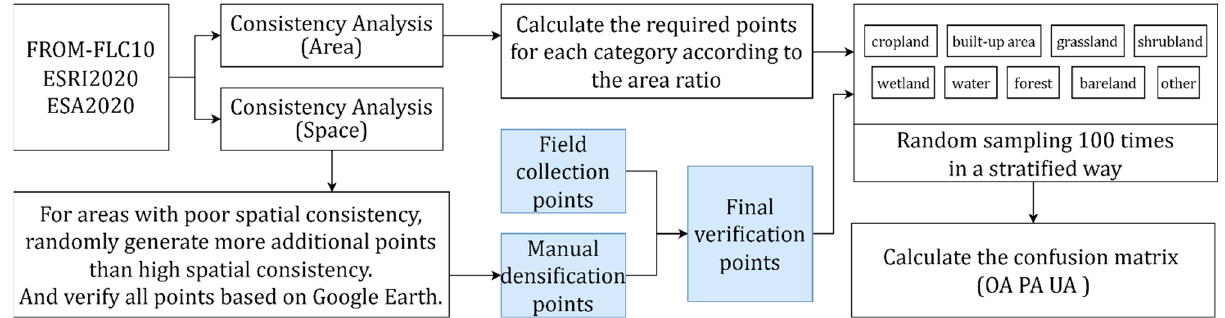
Figure 4. Method flow of validation point processing based on consistency analysis.